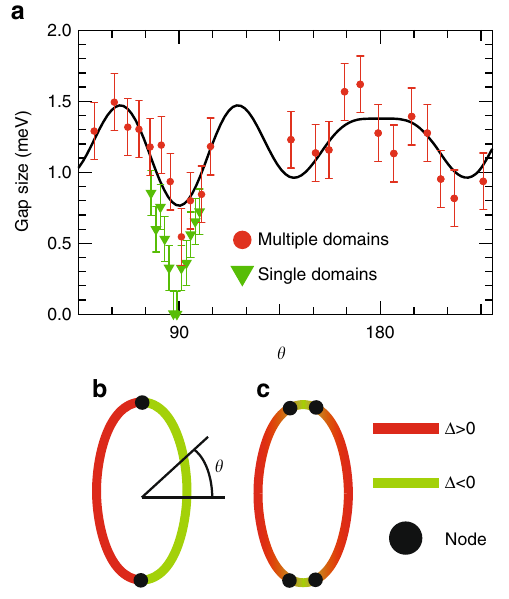
Fig. 5 Superconducting gap anisotropy of multi- and single-domain FeSe. a Superconducting gap anisotropy of the elliptical FS, shown in Cartesian coordinates. Results of the multi-domain samples (red circle) and single- domain samples (green triangle) are shown together. Error bars are determined by the systematic and statistical error of the calibrated E F positions, as explained in Supplementary Note 8. The black curve is fi tting to the observed anisotropy of the multi-domain samples, considering the twofold orthorhombic symmetry. The fi tting function is Δ ð θ Þ ¼ j A þ B cos ð 2 θ Þ þ C cos ð 4 θ Þ þ D cos ð 6 θ Þ þ E cos ð 8 θ Þj . Schematic description of gap signs on the Γ -centered FS assuming b a single node and c two nodes. The red (green) line indicates Δ > 0 ( < 0), and the black circles are the positions of nodes. De fi nition of θ is